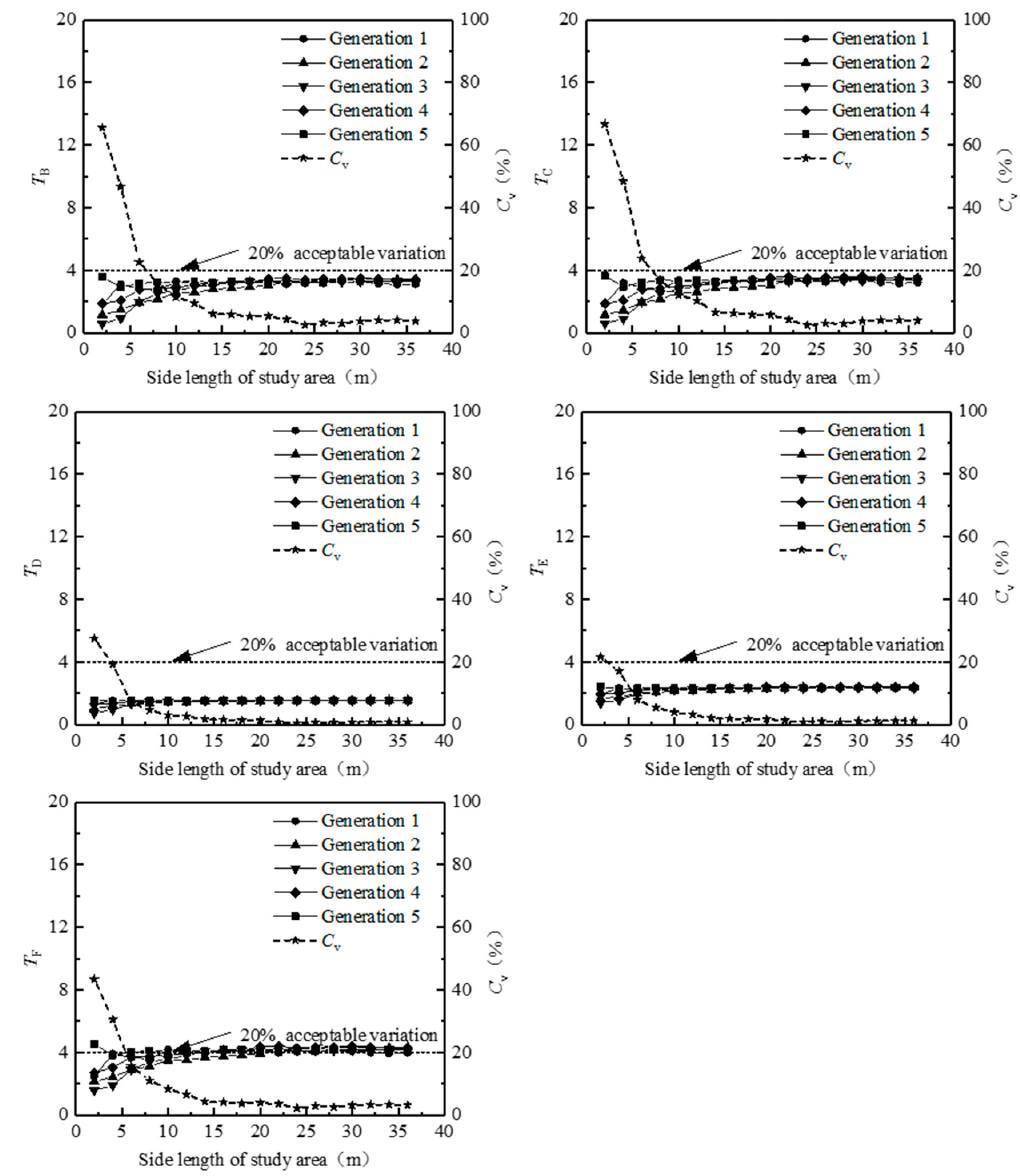
Figure 4. The connection rate ( T X ) and the coefficient of variation ( C v ) versus sample size.